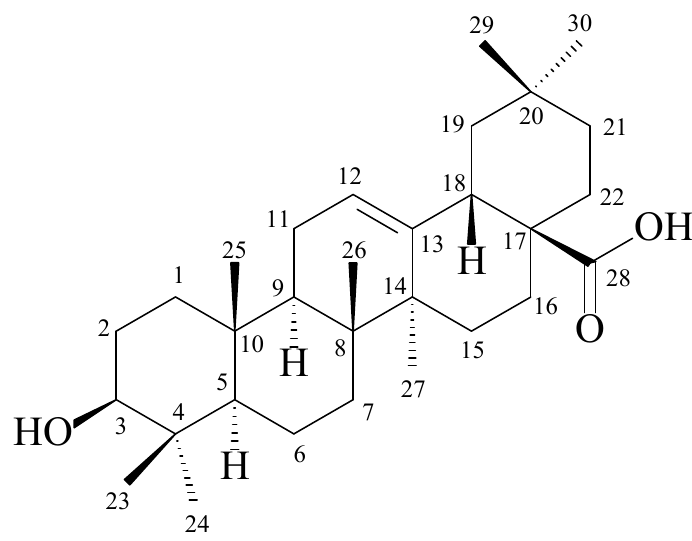
Figure 2. Chemical structure of 1 .